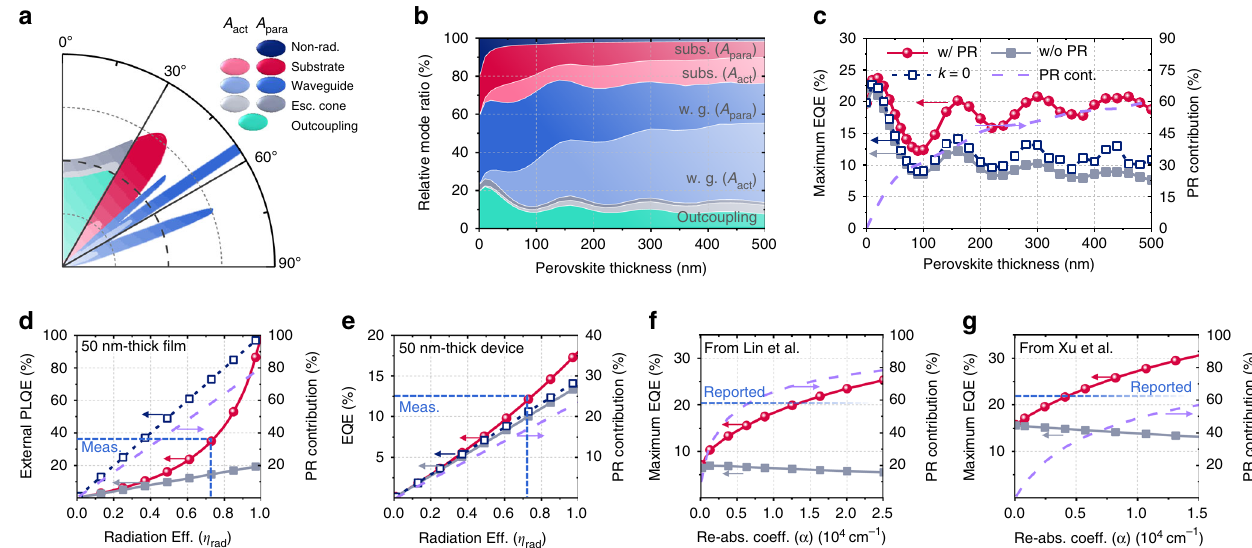
Fig. 3 PeLED analysis using TMF modelling. a Angular mode analysis for PeLED with a structure of glass/ITO (150 nm)/PVK (10 nm)/PEA 2 Cs n − 1 Pb n Br 3n + 1 perovskite (50 nm)/TPBi (50 nm)/LiF (1 nm)/Al. Proportions of active absorption ( A act ) and parasitic absorption ( A para ) for each mode are represented by unique colours in a – b . b Relative ratios of each mode in PeLED for various perovskite thickness. c – g Calculated EQEs (of PL or EL) with PR (closed red circles), without PR (closed grey squares) and without re-absorption (open navy squares), as well as relative PR contribution (violet dashed lines) for c an ideal PeLED (IQE = 100%) with various perovskite thickness; d a 50 nm-thick perovskite fi lm on glass; e a PeLED with 50 nm-thick perovskite ( η inj = 100%); and f – g , the PeLED structures reported by Lin et al. 4 and Xu et al. 5 , respectively, with 100% IQE. For d – g the blue dashed lines compare the graphs with the experimentally measured or reported values. The fact that the calculated η rad (75%) of the PeLED e is almost the same as that of the neat fi lm d indicates that the assumption of η inj = 100% is a good approximation, at least for the voltage of 2.6 V where the maximum EQE occurs. See Supplementary Figs. 10 – 12 for further